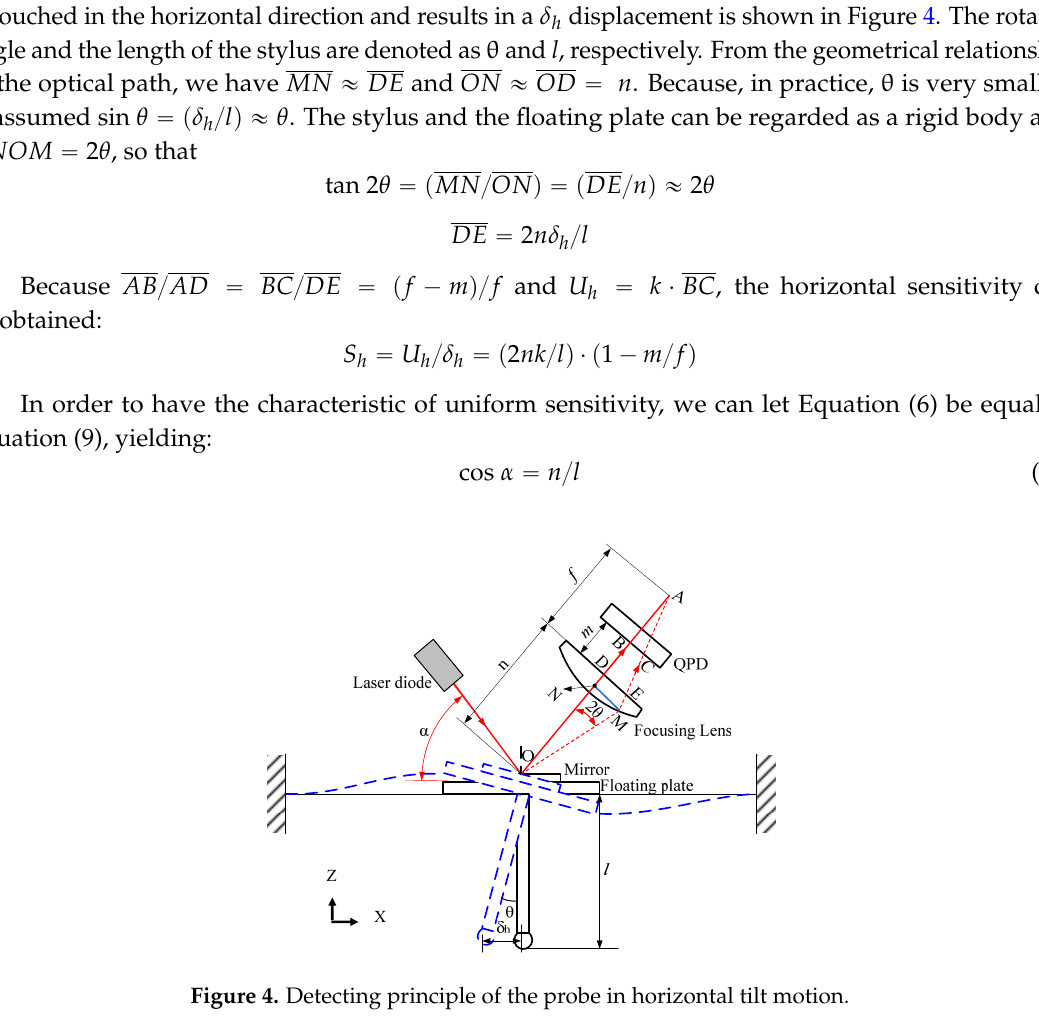
Figure 4. Detecting principle of the probe in horizontal tilt motion.